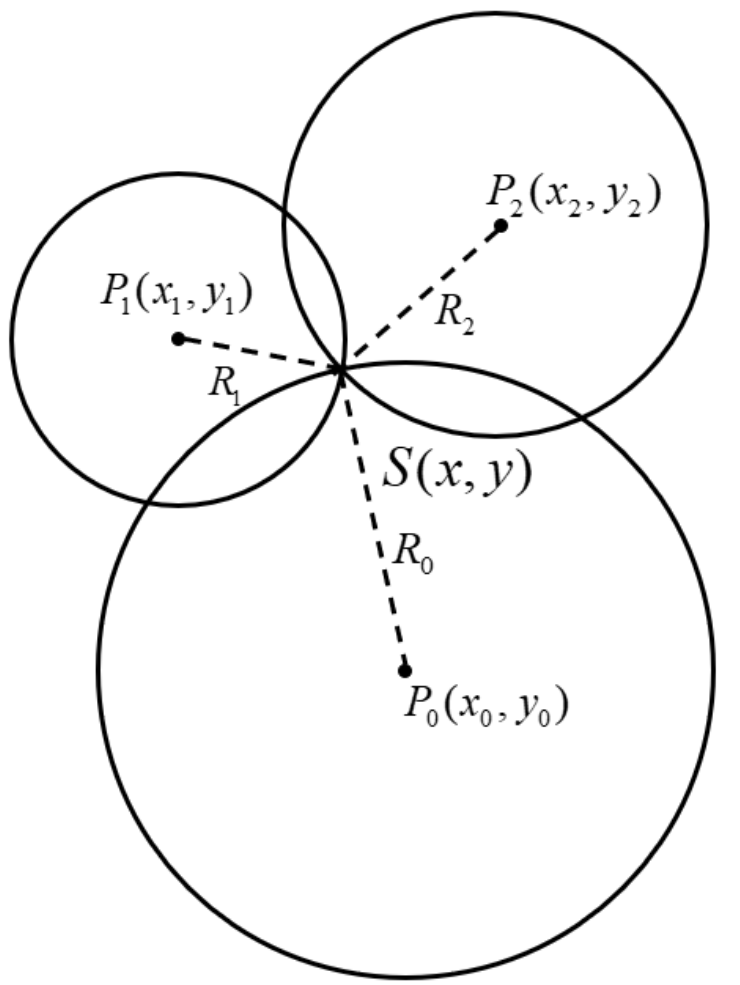
Figure 7. Trilateral measurement algorithm.